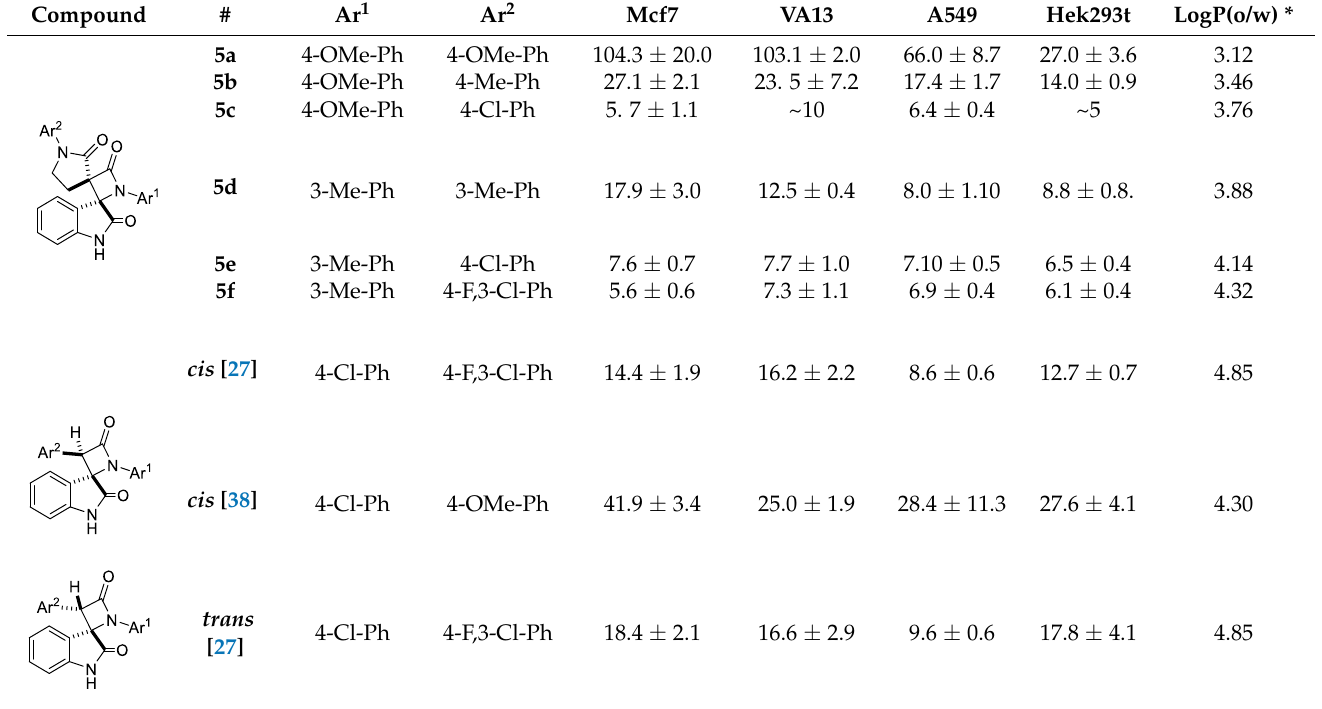
Table 3. IC 50 ( µ M) values and calculated LogP (octanol/water) for dispirooxindole- β -lactams 5a – f and some previously synthesized [25,38] spirooxindole- β -lactams.